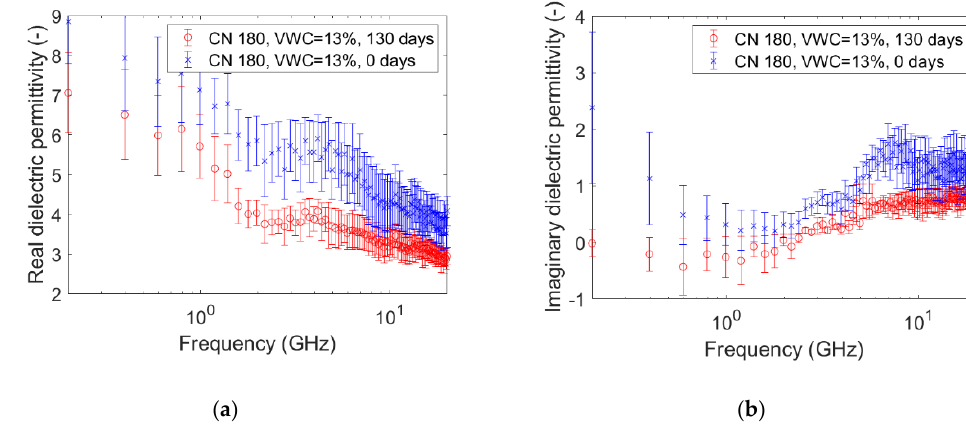
Figure 8. Complex dielectric permittivity before bioremediation and after 130 days: real part ( a ), imaginary part ( b ). Microcosm: C/N = 180. Volumetric water content = 13%.